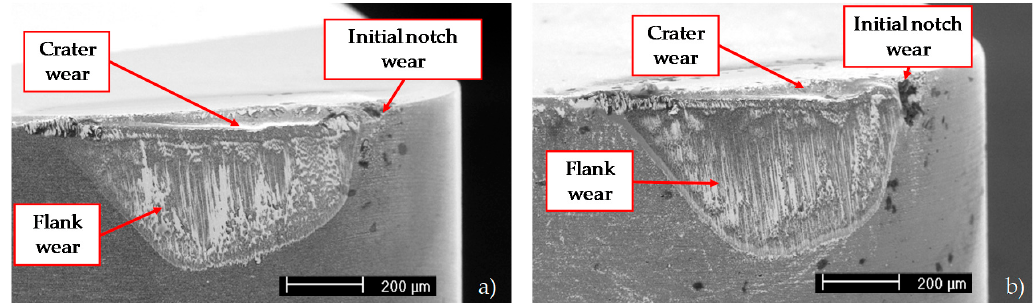
Figure 7. SEM image of PCBN tools at the end of tool life condition. ( a ) Tool grade MB8025, V c = 250 m/min, f = 0.1 mm/rev, d = 0.15 mm; ( b ) tool grade 7015, V c = 300 m/min, f = 0.1 mm/rev, d = 0.15 mm.